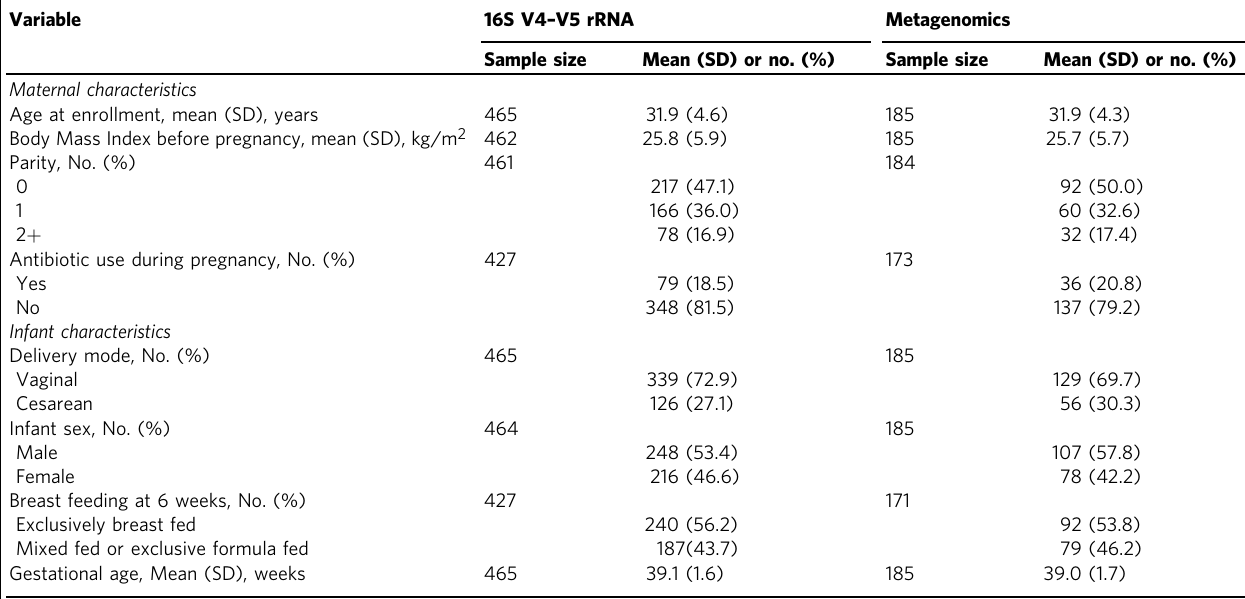
Table 1 Selected baseline characteristics of mothers and infants in the New Hampshire Birth Cohort